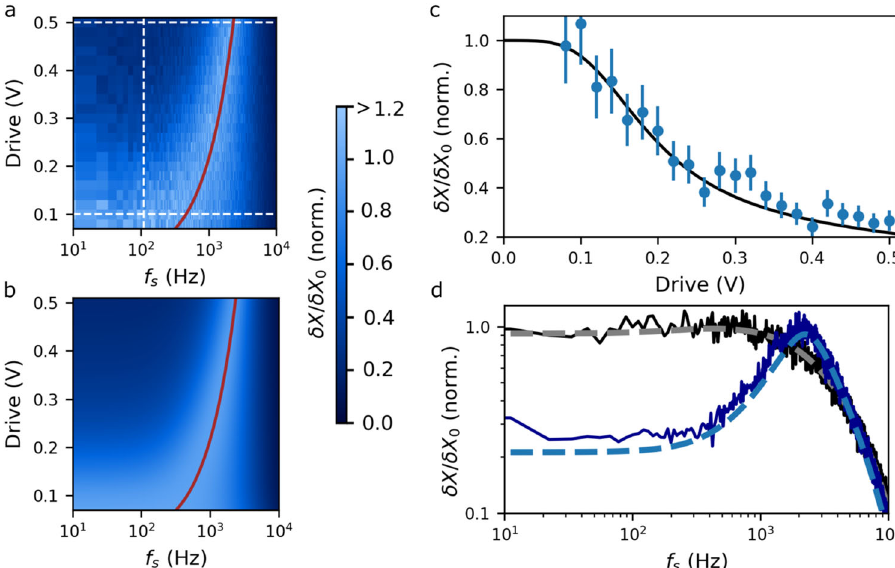
Fig. 4 Amplitude fl uctuations in the synchronization regime at the resonance frequency. The added noise applied to the oscillator is kept fi xed at 0.5 V (standard deviation). The amplitude fl uctuations are normalized to that of the free-running oscillator for the same drive levels (see Fig. S4 and Supplementary Note 2). a Experimental spectral density of the amplitude fl uctuations as the nonlinearity of the oscillator increases. The red line shows the theoretical position of the peak at f s . b Numerical simulation associated to panel ( a ). c Cross-section of panels ( a , b ) near the carrier frequency, peak highlighting the reduction in amplitude fl uctuations as the oscillator enters the nonlinear regime (black line: theory, blue dots: experimental results). The spectral frequency was purposely shifted by ∼ 100 Hz from the carrier frequency to avoid 1/ f noise. The experimental data are the result of an average over 40 measurements, the error bars corresponding to the associated standard deviation. d Cross-section of panels ( a , b ) along 0.1 V (black, linear regime) and 0.5 V (blue, Duf fi ng regime), presenting the evolution of the spectral density from a regime similar to that of a free-running oscillator to the nonlinear regime where the fl uctuations are shifted away from the carrier frequency (dashed line: theory, continuous line: